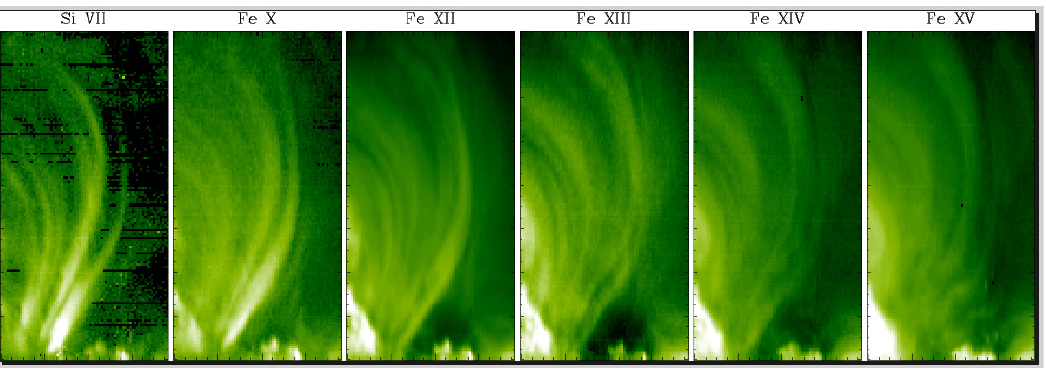
Figure 8: Loop system observed in several EUV spectral lines with Hinode/EIS (19 May 2007, 11:41 – 16:35 UT). The loops become less and less contrasted, i.e., fuzzier and fuzzier, at higher and higher temperature. Courtesy of D.